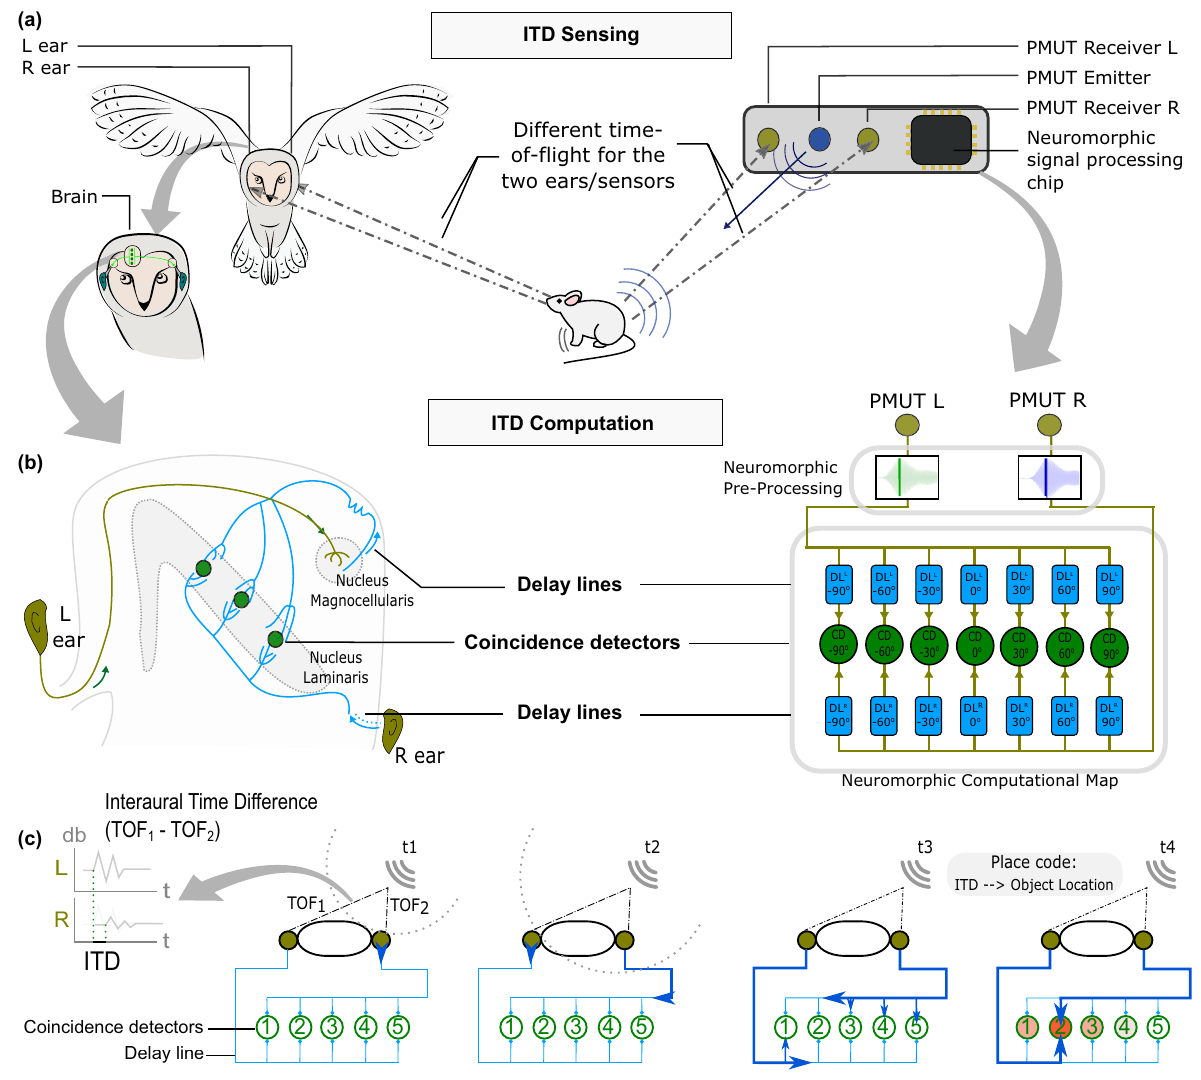
Fig. 1 Object localization system in barn owls and the proposed bio-inspired technology. a The barn owl receives a sound wave from a target, a moving prey in this case. The time-of- fl ight (ToF) of the sound wave at each ear is different (unless the prey is exactly in front of the owl). The dash-dotted lines represent the path of the sound wave toward the barn owl's ears. Based on the difference in the two sound wave path lengths and the corresponding interaural time difference (ITD), it is possible to locate the prey precisely in the horizontal plane (left, fi gure inspired in ref. 74 , Copyright 2002 Society for Neuroscience). In our system, the pMUT emitter (in dark blue) produces a sound wave that bounces off the targeted object. The re fl ected ultrasound wave is sensed by two pMUT receivers (in light-green) and processed by the neuromorphic processor (right). b The ITD computation model (Jeffress model) describes how sounds reaching the barn owl's ears are fi rst encoded into phase-locked spike trains in the nucleus magnocellularis (NM), and then processed using a grid of geometrically arranged coincidence detector neurons in the nucleus laminaris (NL) (left). Illustration of the neural ITD computational map combining delay lines and coincidence detector neurons that can be implemented using RRAM-based neuromorphic circuits to model the owl's biological sensing system (right). c Diagram of the basic Jeffress mechanism, where the two ears receive a sound stimulus at different moments due to a difference in the ToF and send axons to detectors from opposite ends. The axons are afferent to an array of coincident detector neurons (CDs), each of which is selective to highly temporally correlated inputs. As a result, only the CDs whose inputs arrive with the smallest time difference (the ITD is exactly compensated) will be maximally excited. The CDs will then encode the angular position of the model can be found in the nucleus laminaris. They receive input taking the role of CD neurons, whose inputs are delayed by delay from neurons of the nucleus magnocellularis, whose axons serve line circuits (in blue) which act as the axons in the biological as delay lines. The amount of delay provided by delay lines may counterpart. The proposed sensory system diverges from that of be explained by axonal lengths, but also by differential myelina- the owl in terms of operation frequency, the barn owl hearing tion patterns, changing the conduction speeds. Inspired by the system works in the range 1 − 8 kHz, but this work uses pMUT auditory system of the barn owl, we developed a bio-inspired sensors that work at around 117 kHz. The choice of an ultrasound system for object localization. The two ears are represented by the sensor was pondered around engineering and optimization cri- two pMUT receivers. The sound source is a pMUT emitter teria. The fi rst one is that restricting the band of reception to — located in between (Fig. 1a), and the computational map is ideally — a single frequency improves the accuracy of the mea- formed by a grid of RRAM-based CD circuits (Fig. 1b, in green) surement and simpli fi es the post-processing stage. In addition,